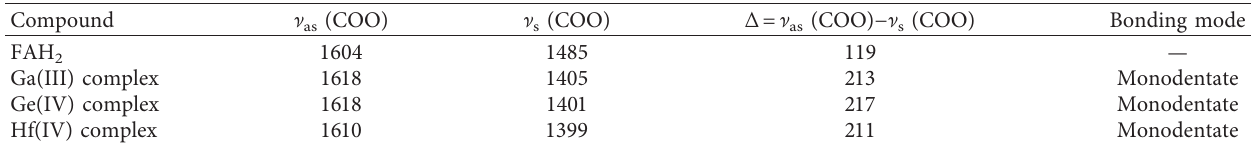
2 and synthesized complexes.